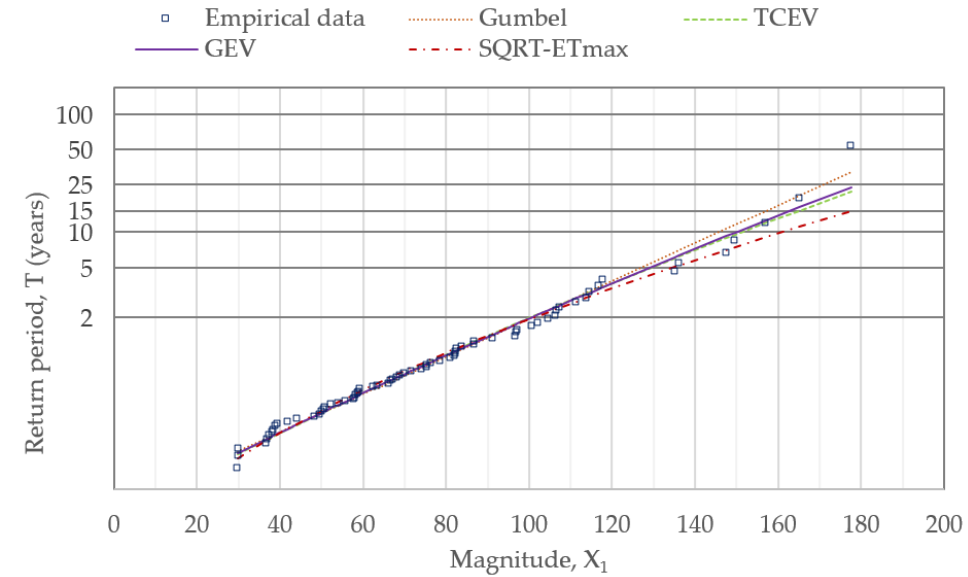
Figure 5. Theoretical distribution functions describing variable X 1 .